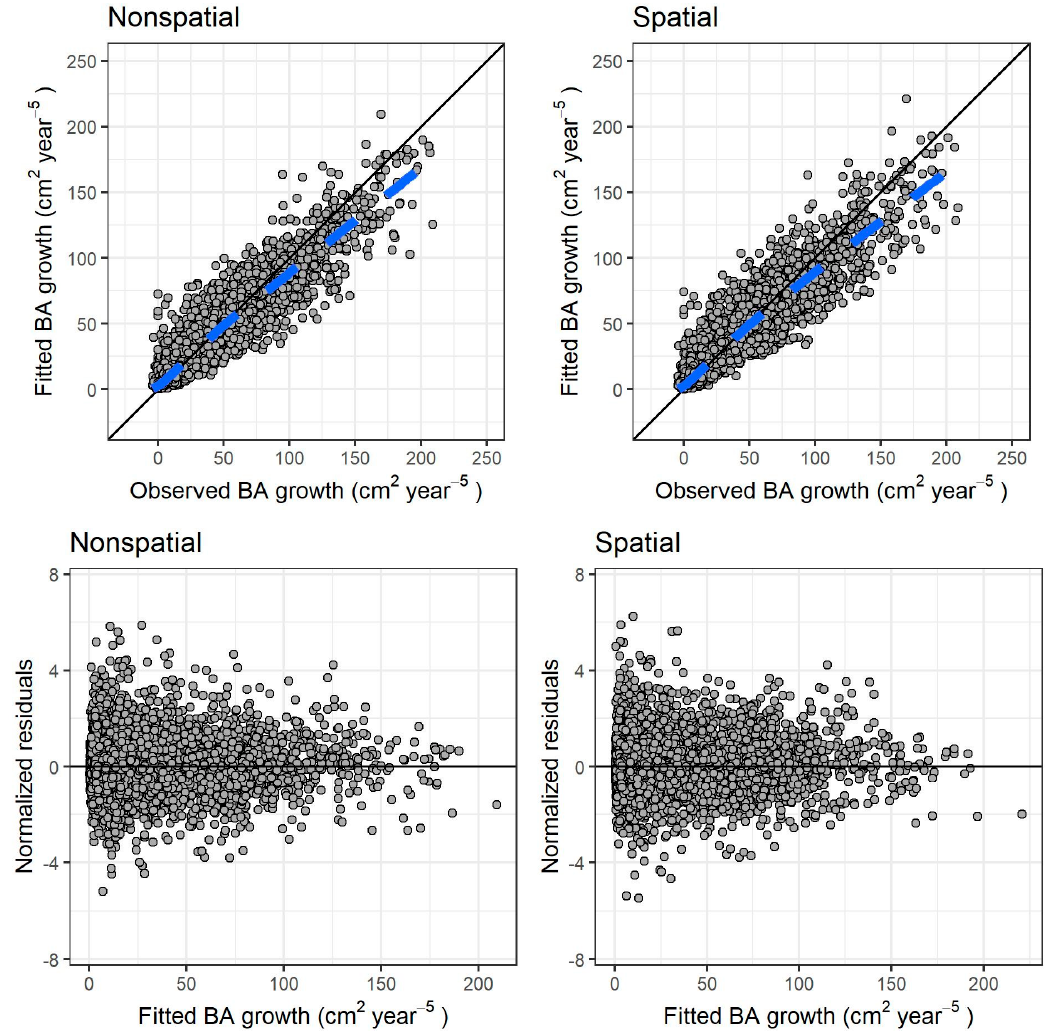
Figure 3. Results for both models of individual tree growth. ( Top row ): fitted versus observed values, respectively, for nonspatial and spatial model (dashed blue line: locally estimated scatterplot smoothing curve, or LOESS, fitted to the scatter plot). ( Bottom row ): normalized residuals versus fitted values, respectively, for nonspatial and spatial model. The continuous black line in all graphs is the identity line.